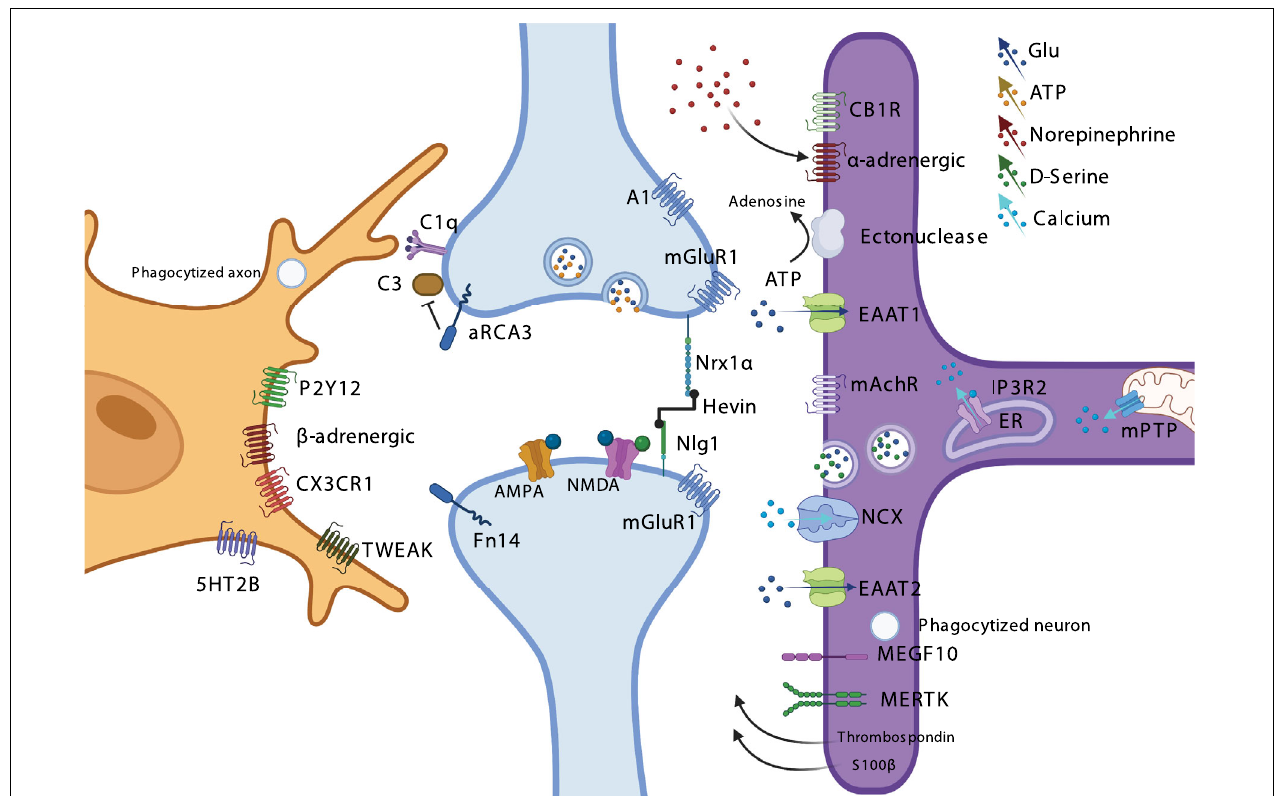
FIGURE 2 | Overview of the signaling mechanisms implicated in neuron-glia communication and interactions throughout the vertebrate visual system. Representative microglial cell (Left, orange), pre- and postsynaptic terminals (Middle, blue), and Müller glial cell/radial astrocyte/astrocyte (Right, purple) expressing a variety of receptors, transporters, channels, and signaling proteins relevant to their functions across the visual